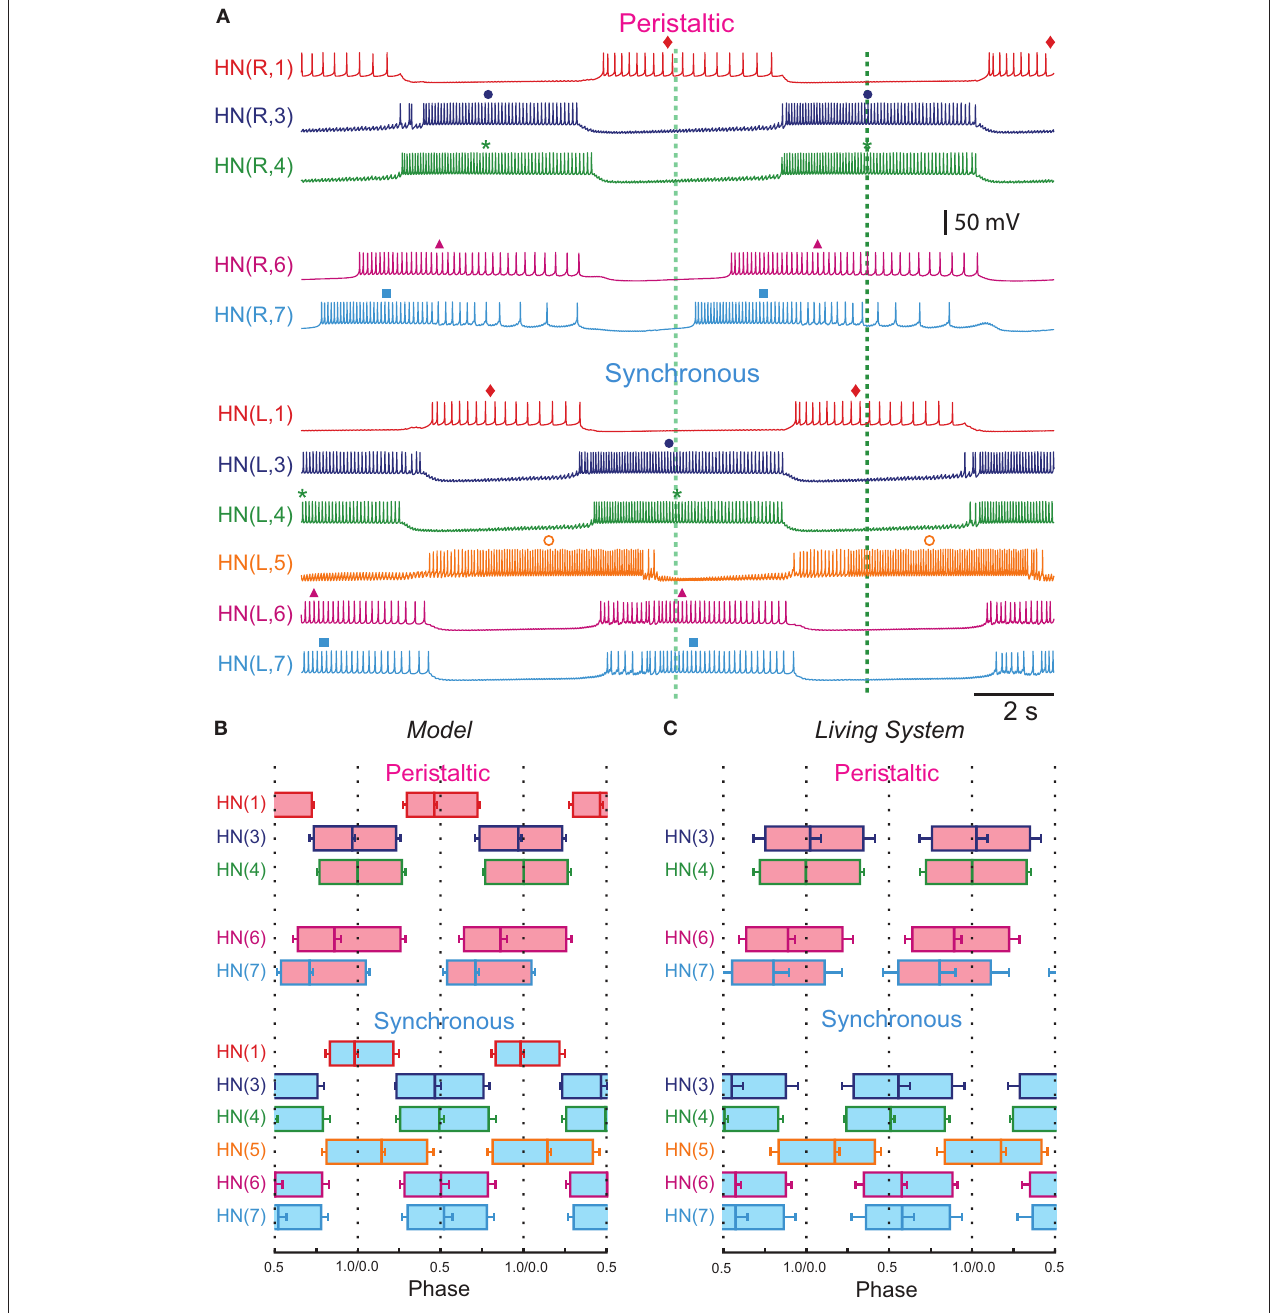
Figure 5 | Model activity with the parameter ( g SynS and g Coup ) values chosen from Figure 3: comparison to the living system. (A) Model recordings showing activity of all identified interneurons of the CPG core except the HN(2) coordinating interneurons, which are identical in activity to and lumped with the HN(1) interneurons (see Materials and Methods), and the inactive HN(5) switch interneuron. Top (R) traces show peristaltic activity and the bottom (L) traces show synchronous activity. The dark/light green dashed line indicates the firing phase of the peristaltic/synchronous HN(4) interneuron. (B) Phase diagram of